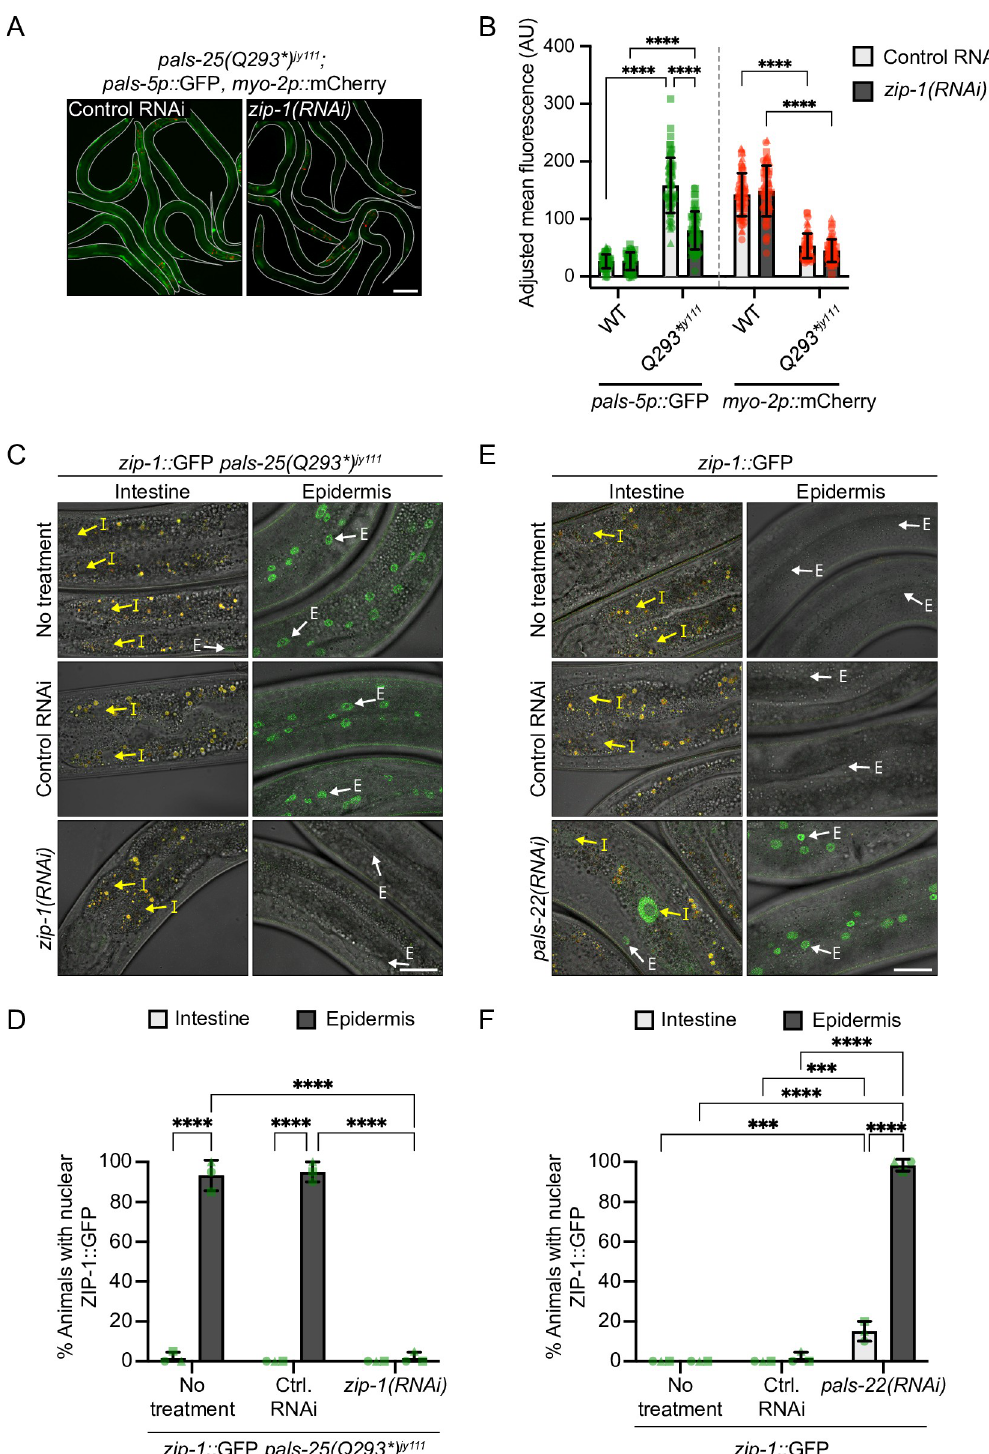
Fig 5. PALS-25(Q293 � ) and loss of PALS-22 both increase ZIP-1 nuclear localization in the epidermis. A) Constitutive expression of pals-5p ::GFP in pals-25(Q293 � ) jy111 mutants is suppressed upon treatment with zip-1 RNAi. L4s are shown, with lines denoting the outline of the body. Scale bar = 100 μ m. B) Quantification of pals-5p ::GFP and myo-2p ::mCherry mean fluorescence signal normalized to body area for RNAi-treated L4s. Symbols represent fluorescence measurements for individual animals, n = 60 animals per treatment. C, D) ZIP-1::GFP is constitutively expressed in the epidermis but not